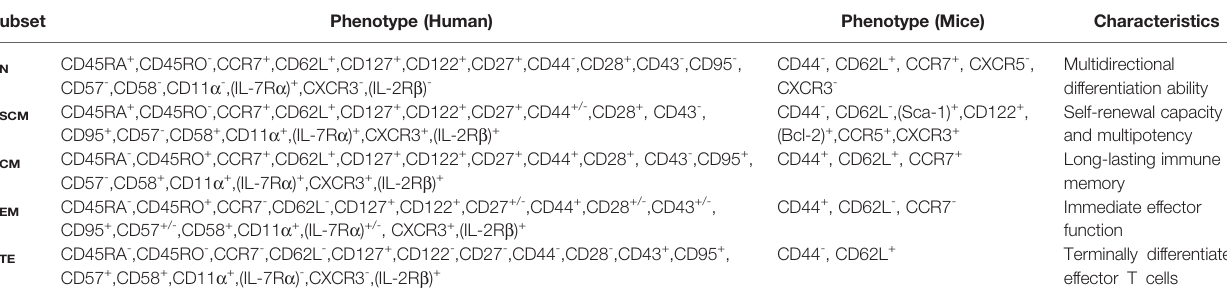
TABLE 1 | Phenotypic markers of memory T